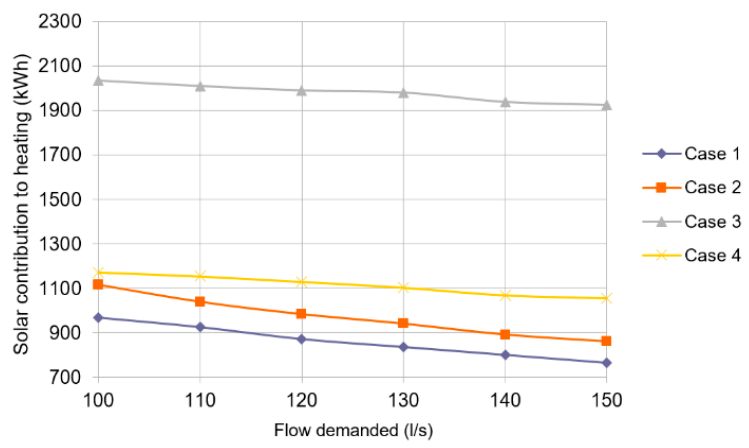
Figure 4. Solar contribution to heating in Cases 1–4.